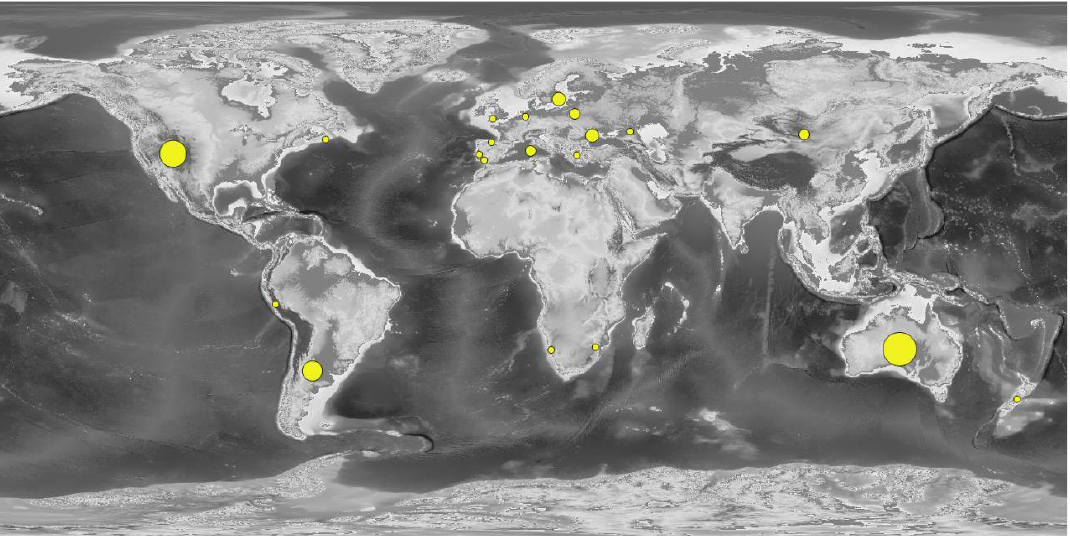
Figure 2. Feral horse populations provided as example in Table 2. The size of the dot is proportional to their population size. Note that the aim of this map is not to include all world populations, but a sample of the different environments used by feral horses. Background map modified from GEBCO Compilation Group (2019) GEBCO 2019 Grid (https://doi.org/10.5285/836f016a-33be-6ddc-e053-6c86abc0788e accessed on 1 October 2021).